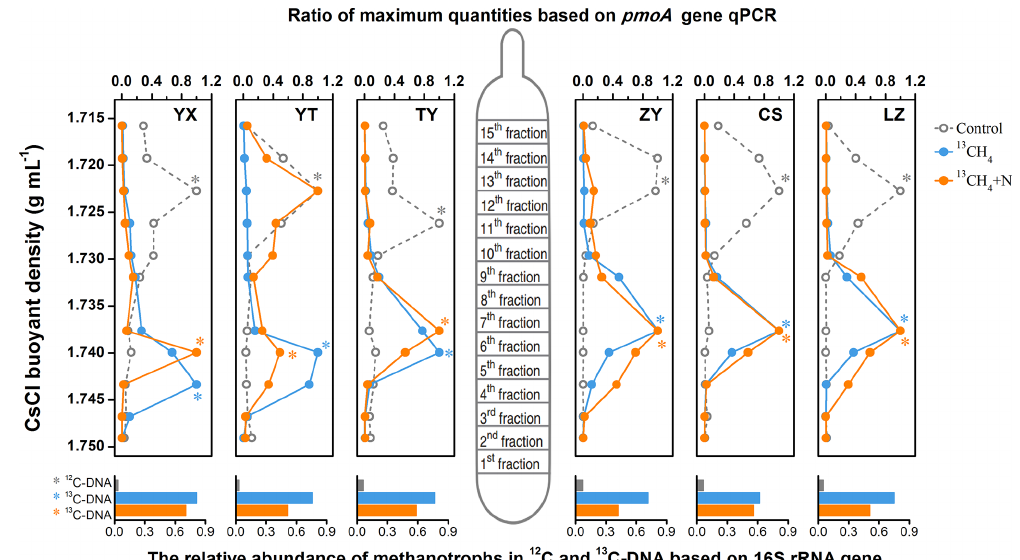
Figure 2. The distribution of 13 C-labeled methanotrophs based on qPCR of pmoA and sequencing of 16S rRNA genes. The 13 C-labeled methanotrophs were determined by quantitative distribution of pmoA genes across the entire buoyant density gradient of the DNA fractions from soil microcosms incubated with 13 CH 4 compared to the controls. The normalized data are the ratios of the gene abundance in each DNA gradient to the maximum number for each treatment. The columns beneath display the relative abundance of methanotroph-affiliated reads in all 16S rRNA genes in the 12 C-DNA from the control and 13 C-DNA from 13 CH 4 -amended soil microcosms, respectively. ∗ The DNA fractions selected for Illumina